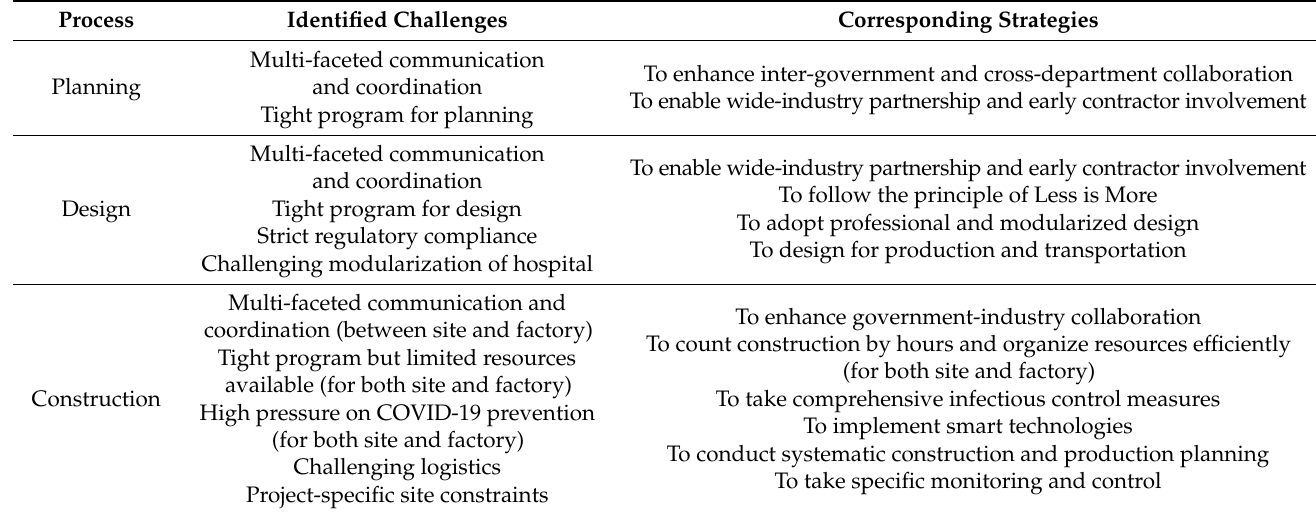
Table 3. Challenges and strategies of delivering modular healthcare facilities for